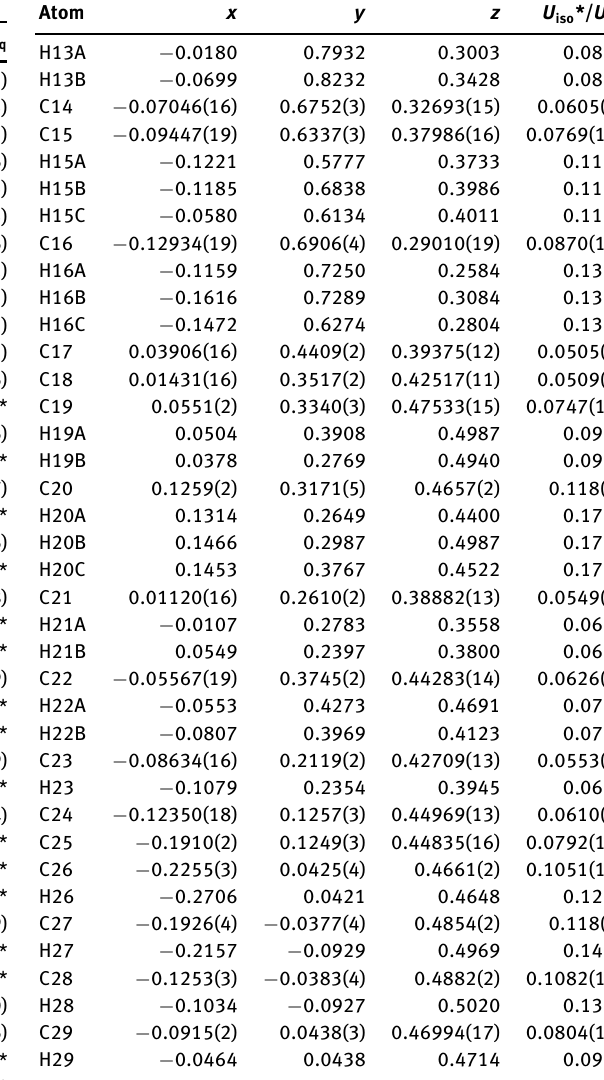
Table 2: Fractional atomic coordinates and isotropic or equivalent isotropic displacement parameters (Å 2